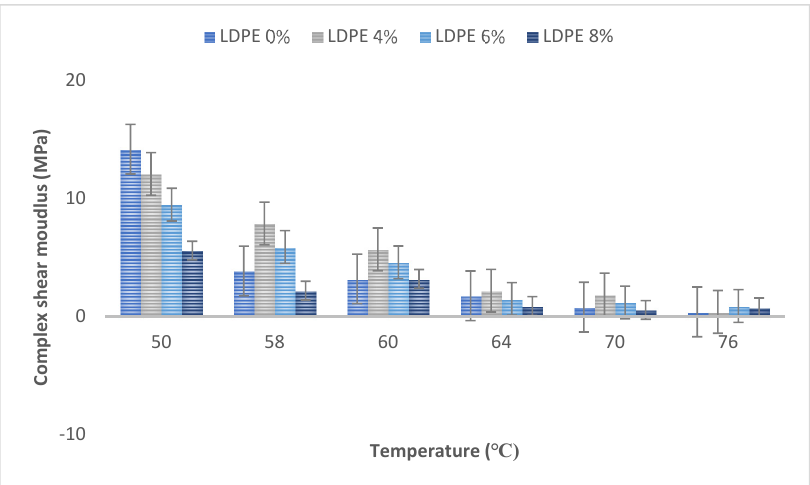
-10 Figure 9. LDPE waste plastic effects on the complex shear modulus. Figure 9. LDPE waste plastic effects on the complex shear